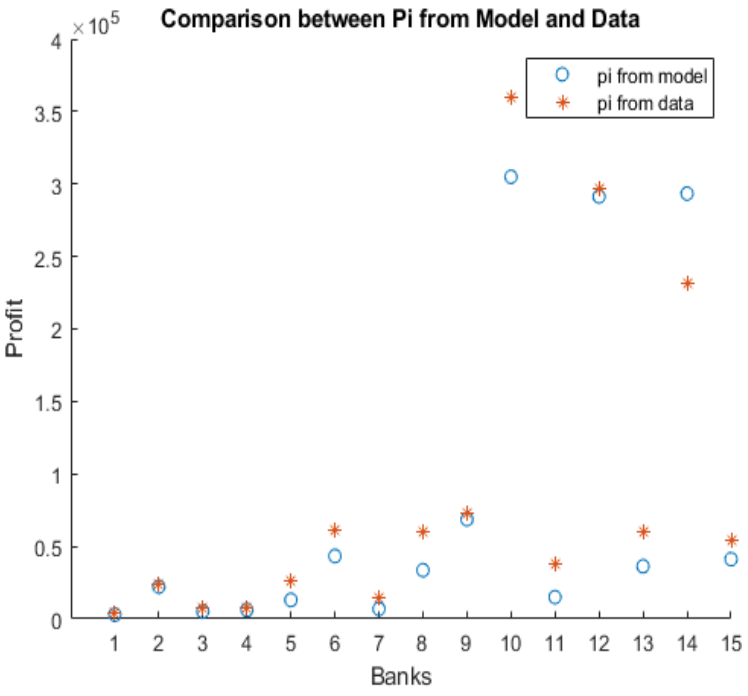
Figure 3. Model Fit: Profit. Notes: This figure depicts the profit in the data and calibrated profit in the model in 2014. Table 3. Calibration Result: µ and ϕ